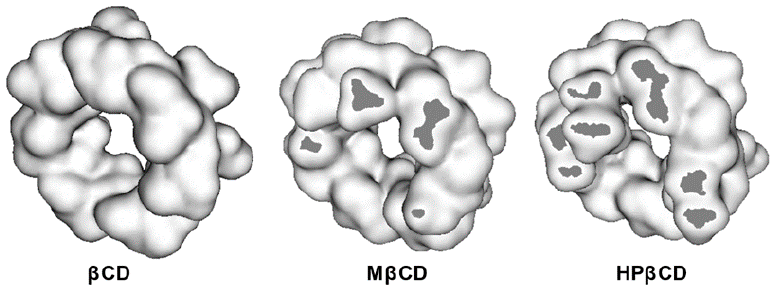
Figure 5. 3D representation (figure adapted from [28]) of native β CD, M β CD, and HP β CD. Dark grey sections represent the steric hindrance generated by the different type of substituent group.